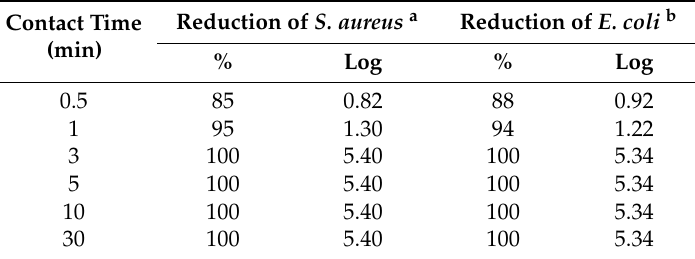
Table 3. The antibacterial property of fabrics against S. aureus and E. coli